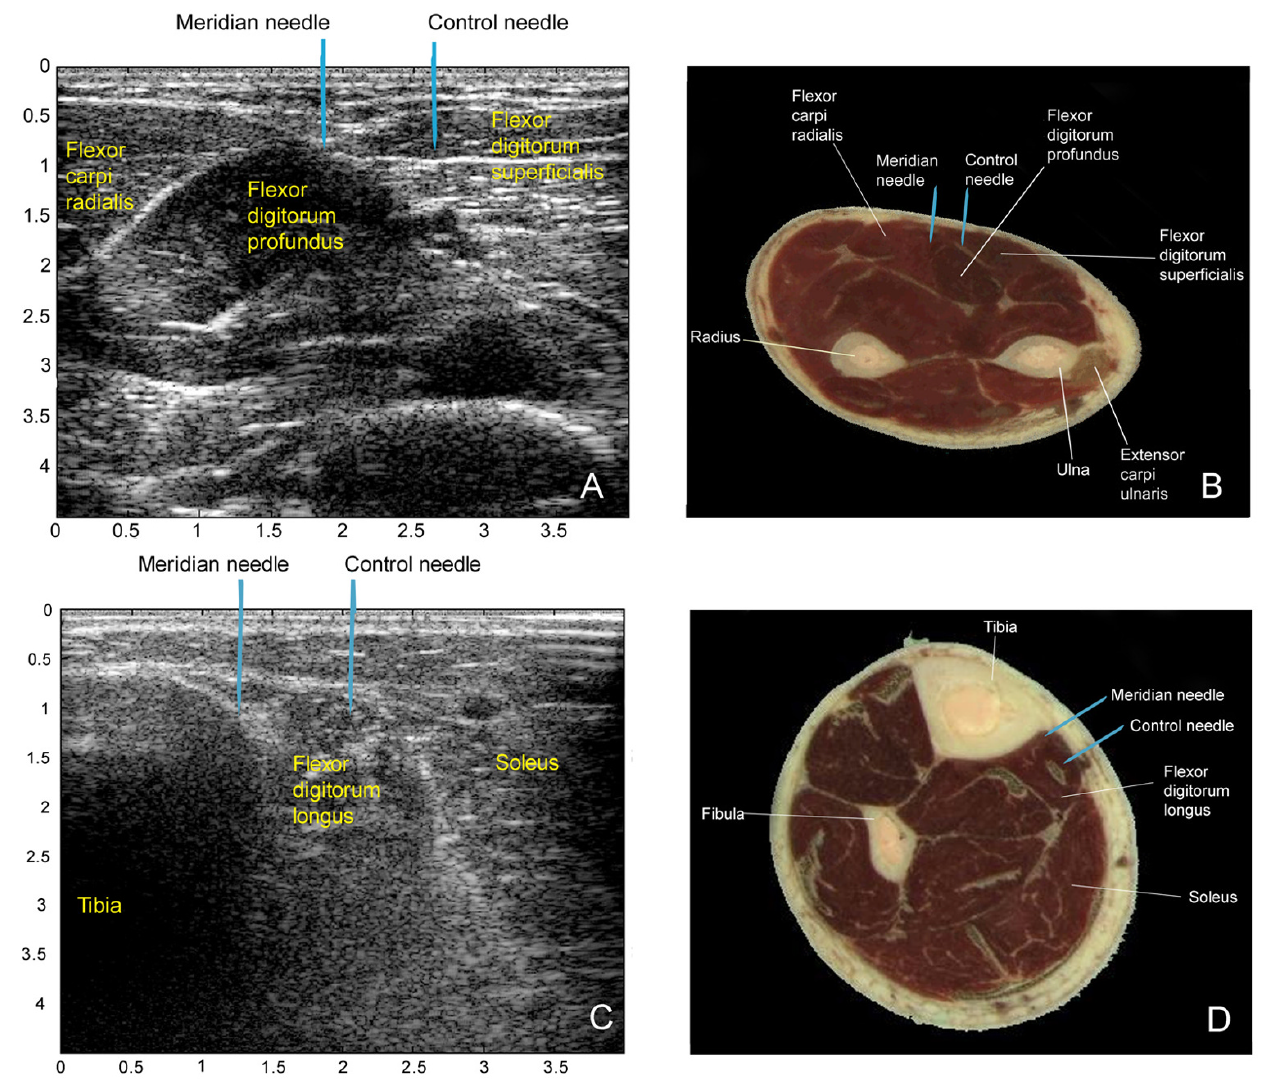
Depiction of the Spleen and Pericardium meridians in relation to surface and sub-surface anatomical land- marks. 2 A, B: Cross sectional images of the right forearm as shown through ultrasound and gross anatomical cross section (obtained from the Visual Human Database). The Pericardium segment is located between the flexor carpi radialis and flexor digitorum superficialis muscles. 2 C, D: Cross sectional images of the right leg as shown through ultrasound and cadaveric cross section. The Spleen segment is located between the medial crest of the tibia and the flexor digitorum longus muscle. Blue arrows point to approximate sites where meridian and control needles were